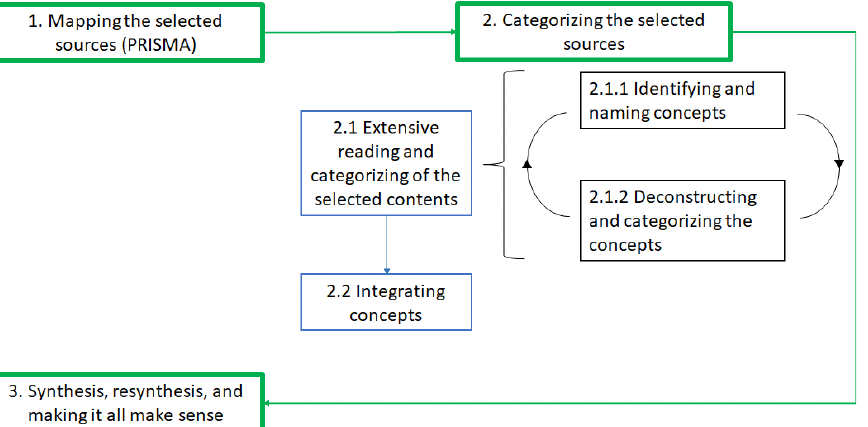
Figure 1. CM development methodology.